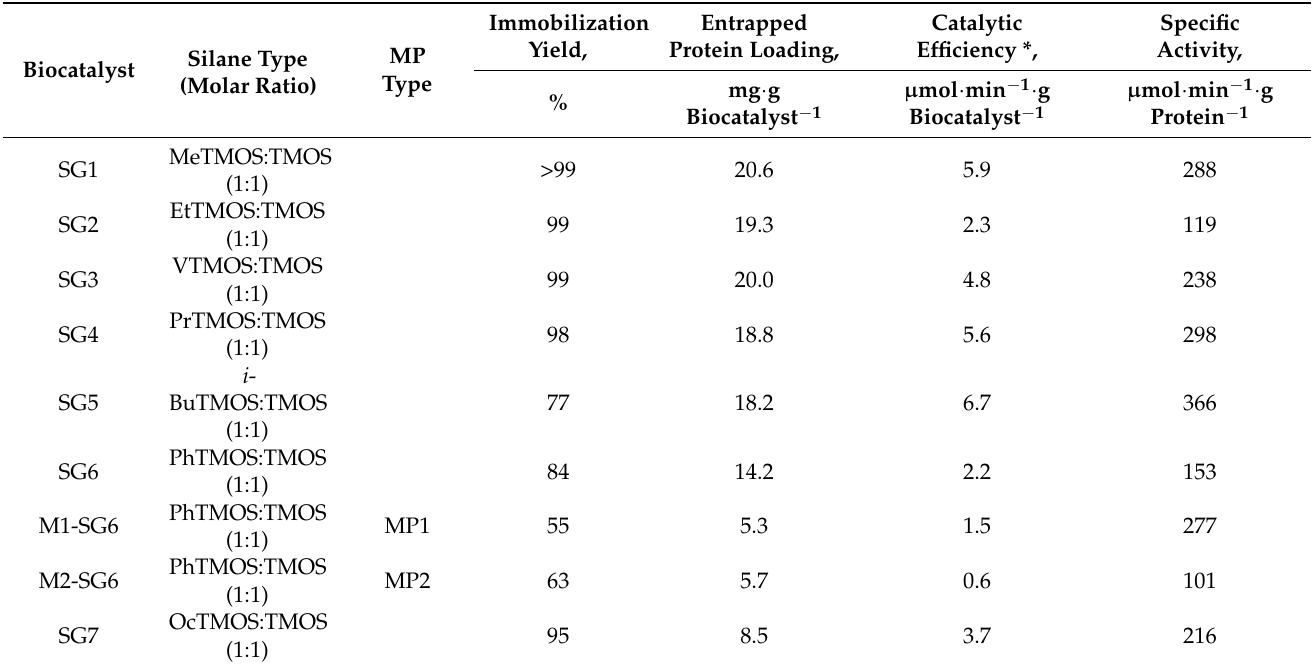
Table 1. Influence of the binary silica network on the immobilization yield and catalytic efficiency of the immobilized biocatalysts by their entrapment in sol–gel and magnetic